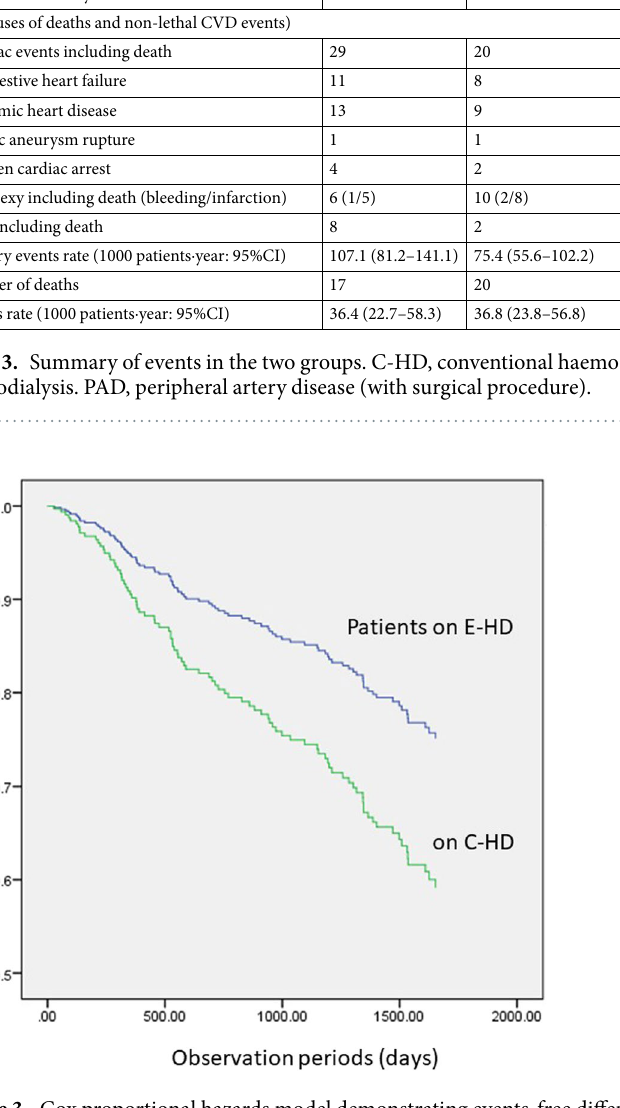
Figure 3. Cox proportional hazards model demonstrating events-free differences between patients on C-HD and those on E-HD. Treatment with E-HD was an independent predicting factor for events (hazard ratio:0.593; p < 0.05). Abbreviations: C-HD, conventional haemodialysis; E-HD, electrolyzed water